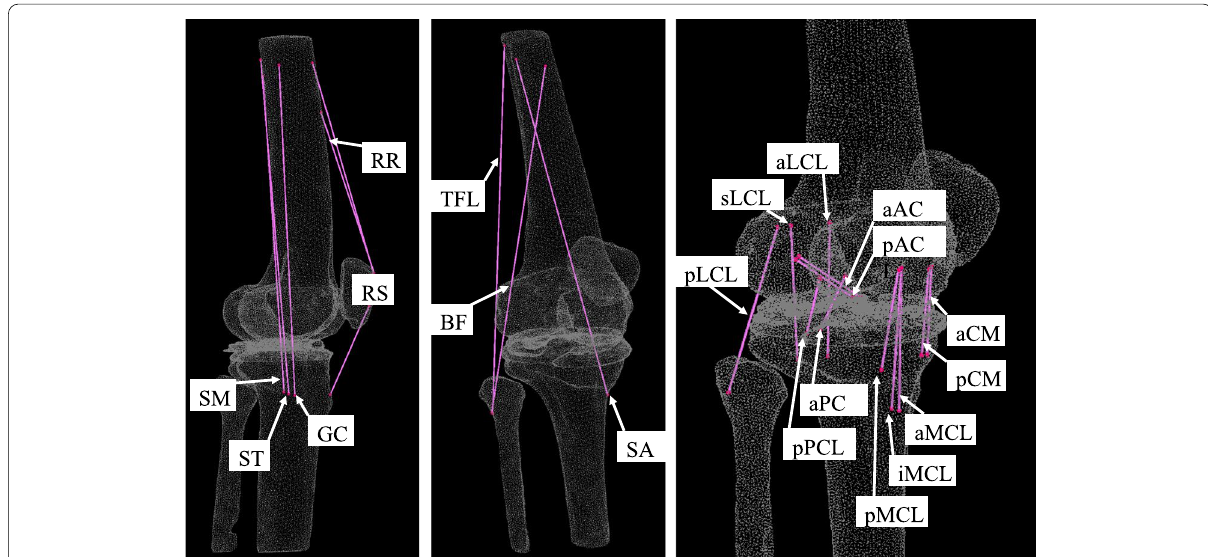
Fig. 2 Finite element model with each of the ligaments and muscles. FE models, which were constructed from the left femur, patella, tibia, and fibula, were equipped with triangular shell elements (thickness, 2 mm; size, 3 mm) for the outer surface of the cortical bone and tetrahedral solid elements with a size of 2 mm. Ligaments and soft tissues around the knee joint were used in accordance with previous reports. RS; Rectus femoris (straight head), RR; Rectus femoris (reflected head), TFL; Tensor fasciae latae, SA; Sartorius, SM; Semimembranosus, ST; Semitendinosus, BF; Biceps femoris, GC; Gracilis, ACL; anterior cruciate ligament, PCL; posterior cruciate ligament, LCL; lateral cruciate ligament, MCL; medial cruciate ligament, MC; medial capsule